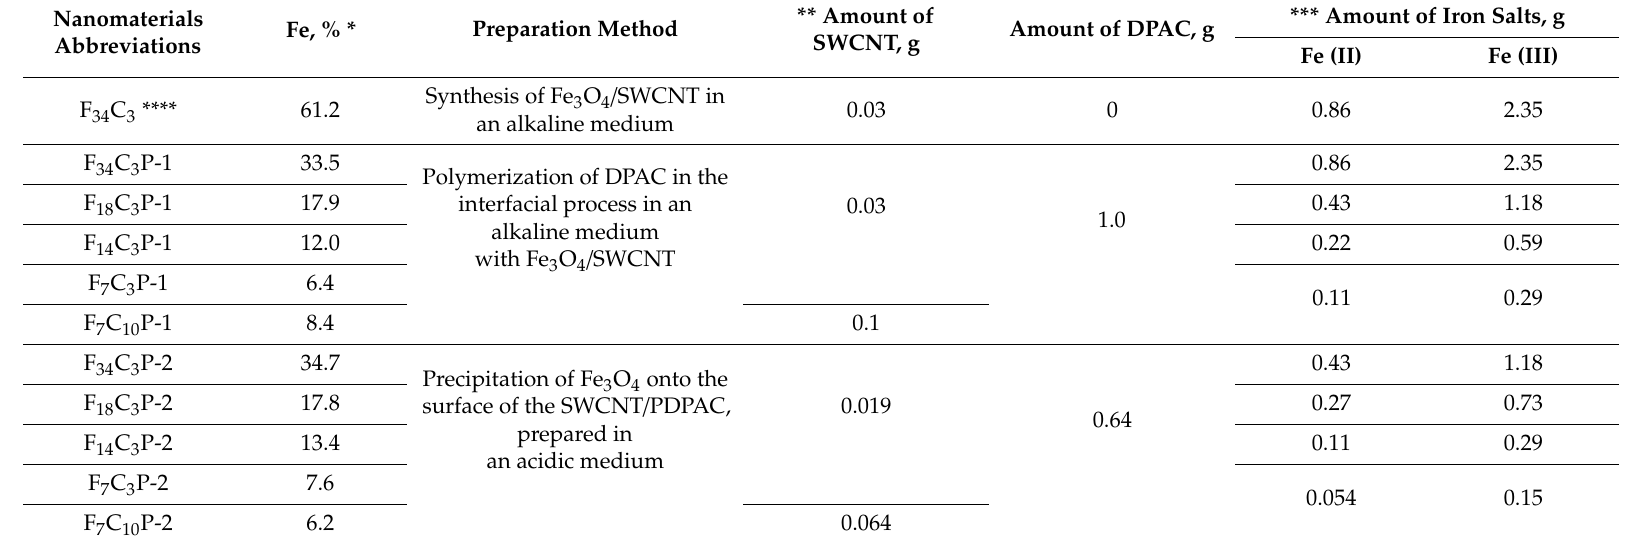
Table 1. Conditions for synthesis of Fe 3 O 4 / SWCNT and Fe 3 O 4 / SWCNT / PDPAC